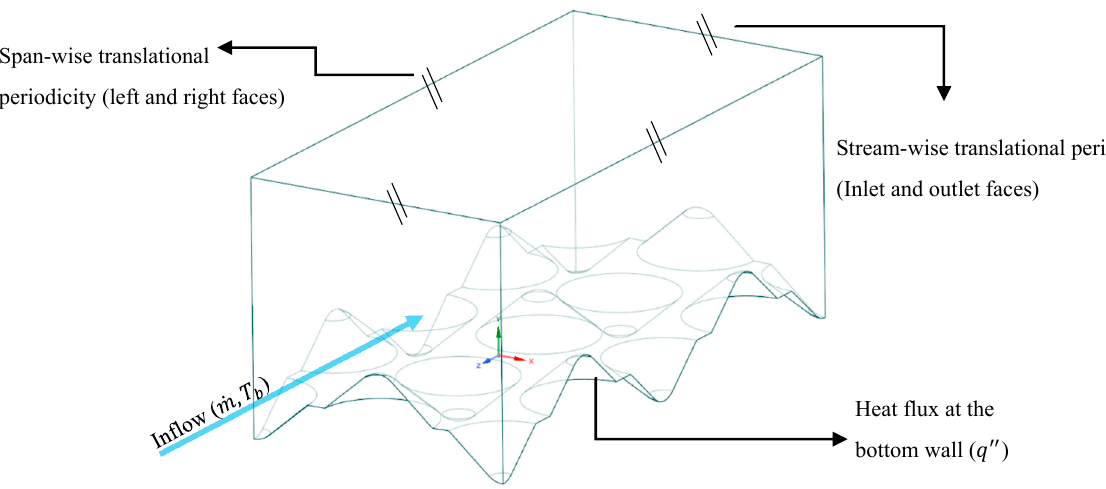
Figure 2. The computational domain and boundary conditions for the roughness model.